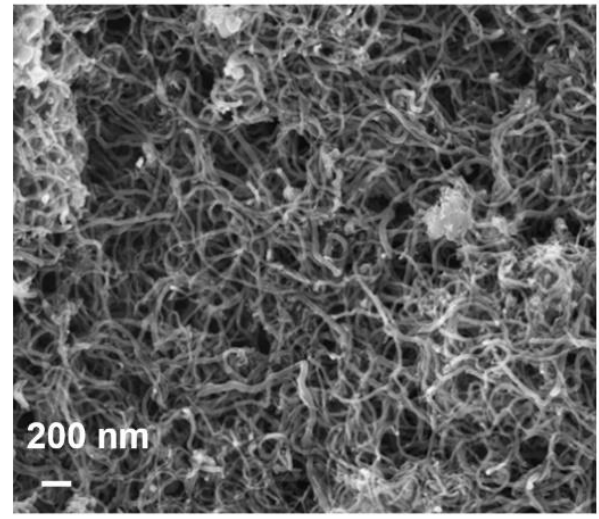
Figure 1. Scanning electron micrograph of O-MWCNTs.